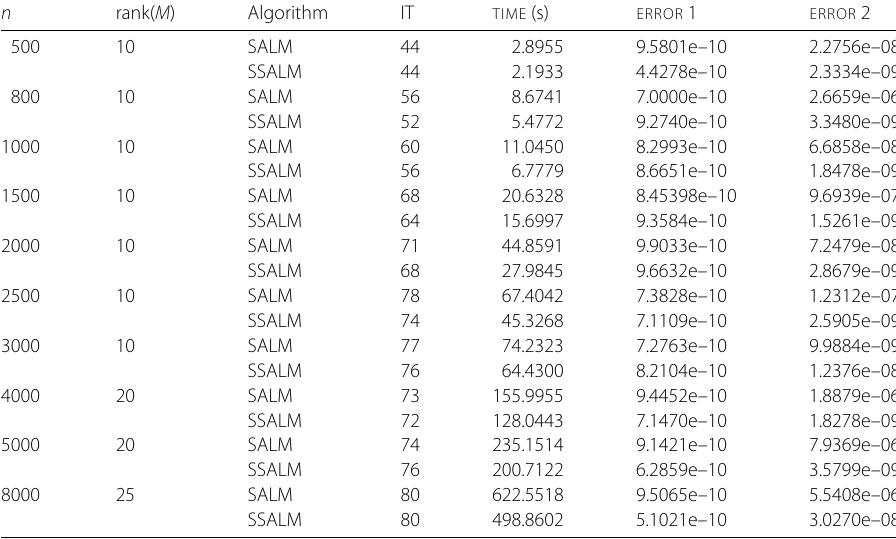
Table 2 Comparison between SALM and SSALM for p =